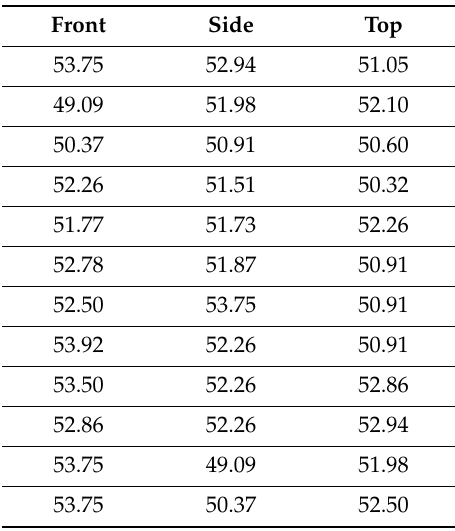
Table 17. DOE setup for UTS as a function of build